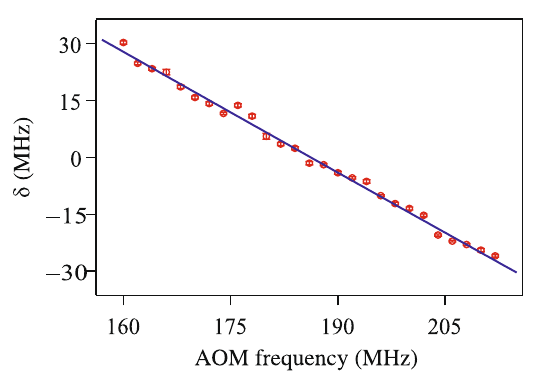
Figure 4. Peak separation δ (as defined in the text) plotted as a function of AOM frequency. The solid line is a weighted second-order polynomial fit, weighted by the error bar for each point. The error bar for each point is smaller than the symbol, and not seen clearly.